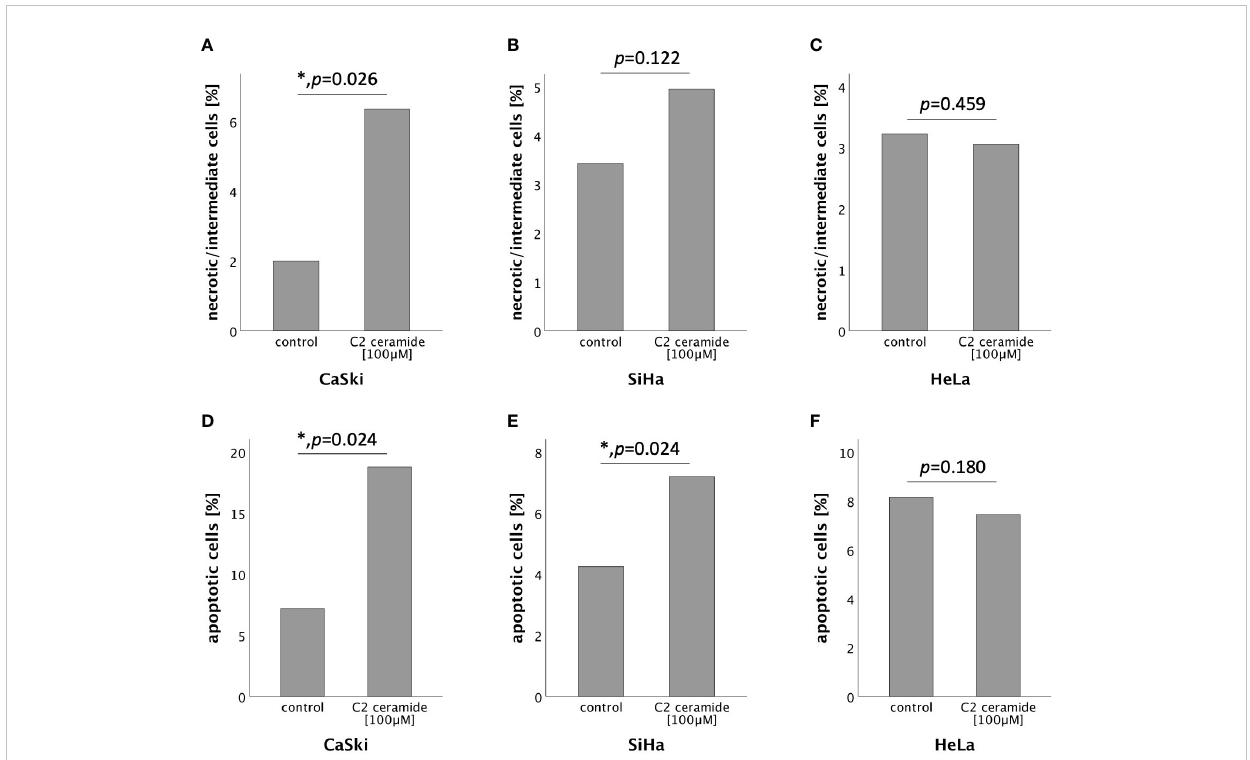
FIGURE 6 AnnexinV-FITC apoptosis staining followed by FACS comparing the percentual number of necrotic/intermediate cells of the control with the C2 ceramide treated cells (A – C) . AnnexinV-FITC apoptosis staining followed by FACS comparing the percentual number of apoptotic cells of the control with the C2 ceramide treated cells (D – F)